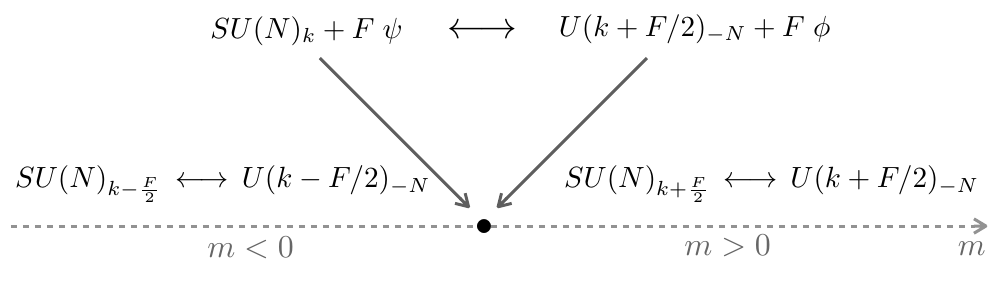
Figure 1 . Phase diagram of SU ( N ) k + F in the case k (cid:21) F= 2. The phase transition between the two gapped phases is indicated by the black